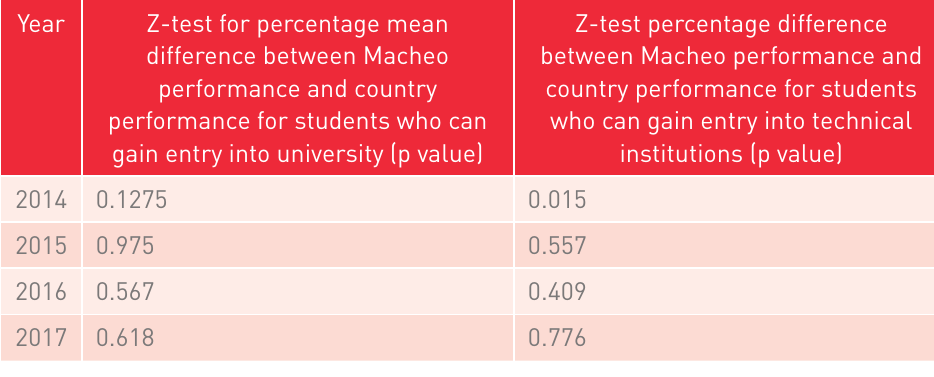
Z-test percentage difference between Macheo performance and country performance for students who can gain entry into technical institutions (p